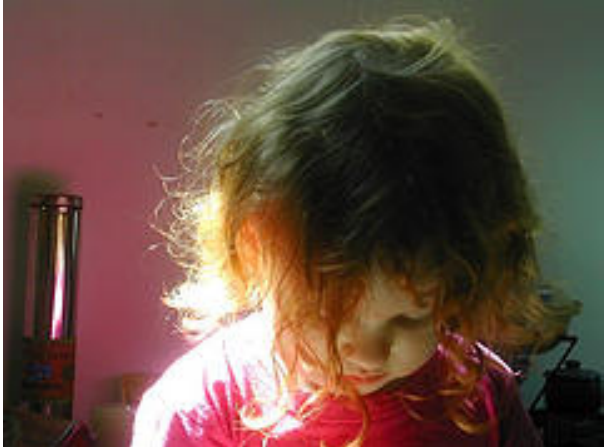
Figure 9: ‘When I Look’ by Melanie